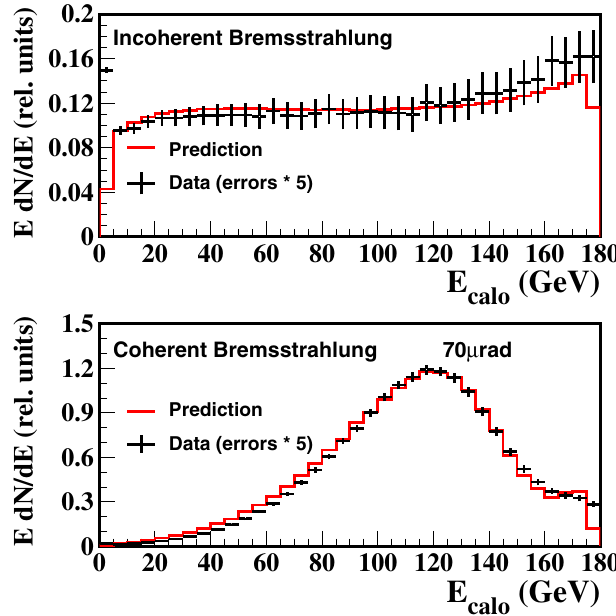
FIG. 13. (Color) Power spectrum for incoherent (top) and for coherent bremsstrahlung (bottom) as a function of the total detected in the calorimeter. Vertical axis: Power energy E calo (relative units). The statistical errors on the data are enhanced by a factor of 5 to increase